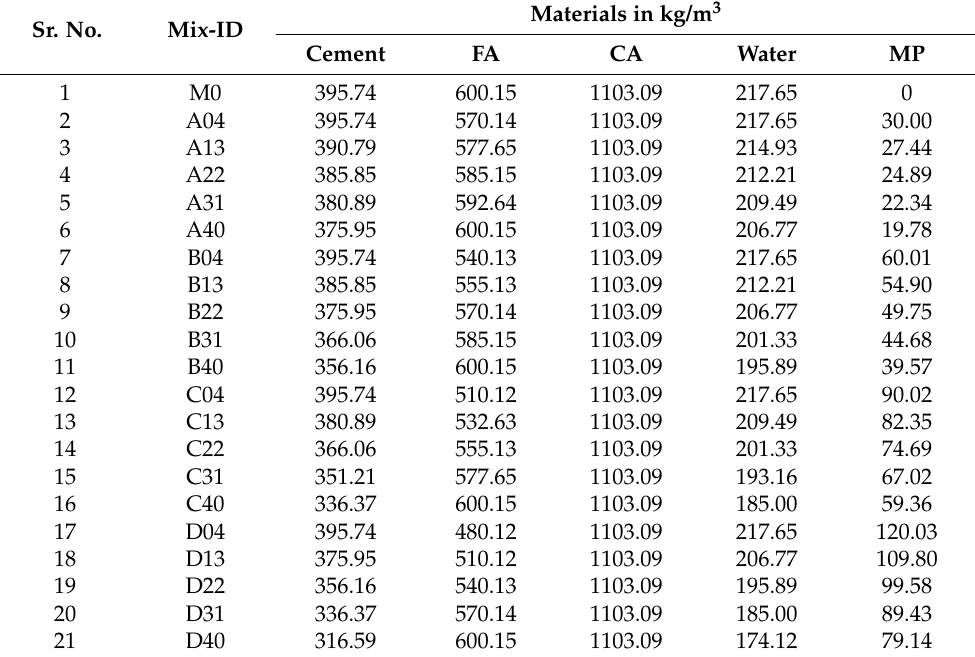
Table 4. Mix Design.